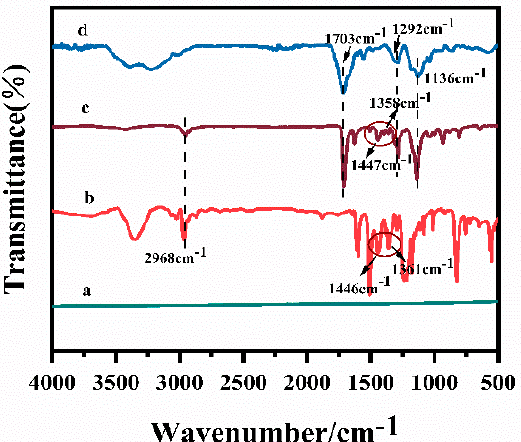
Figure 3. FTIR spectra of the CF (a), BPA (b), BPA–MIP@CF (c) and MIP@CF